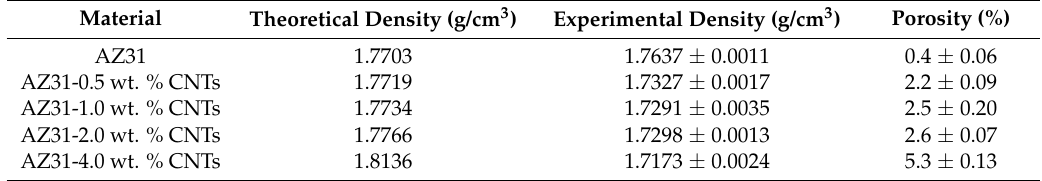
Table 2. Theoretical and experimental densities of AZ31 and its nanocomposites. CNTs: carbon